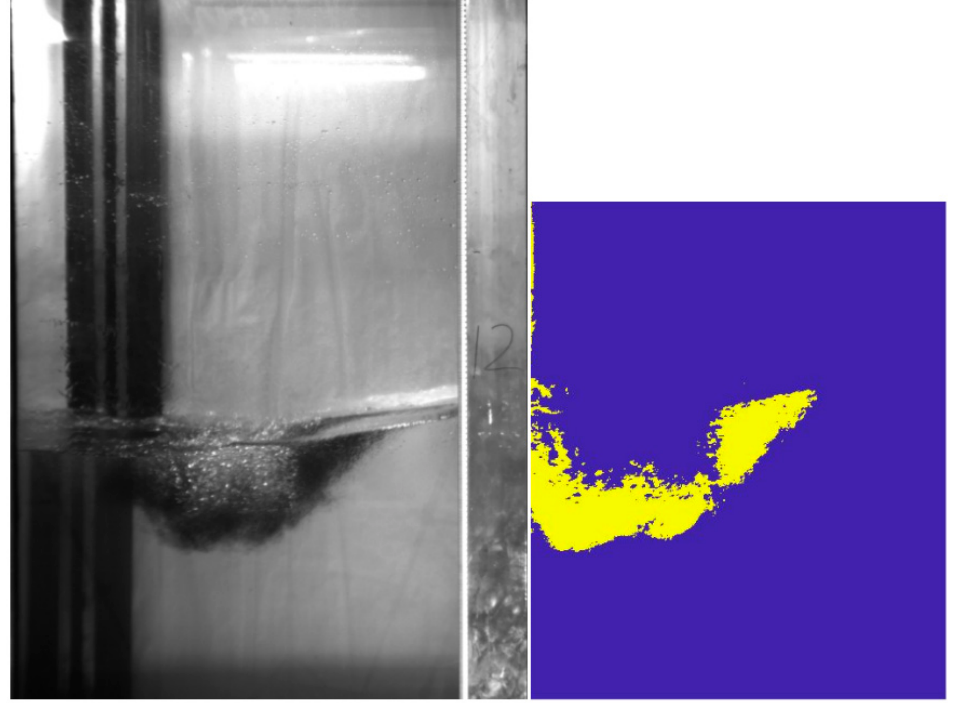
Figure 11. Spilled oil in the deepest position of observation area under 25 cm breaking wave.